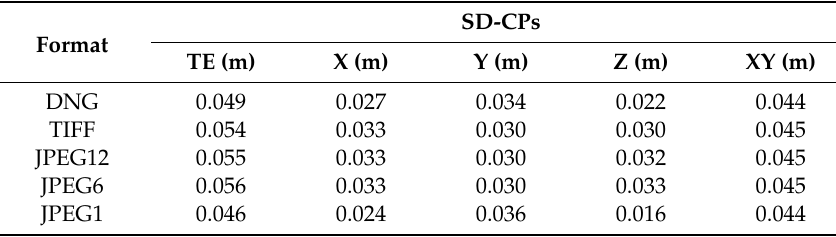
Table 7. Evaluation of the accuracy on CPs—Test site